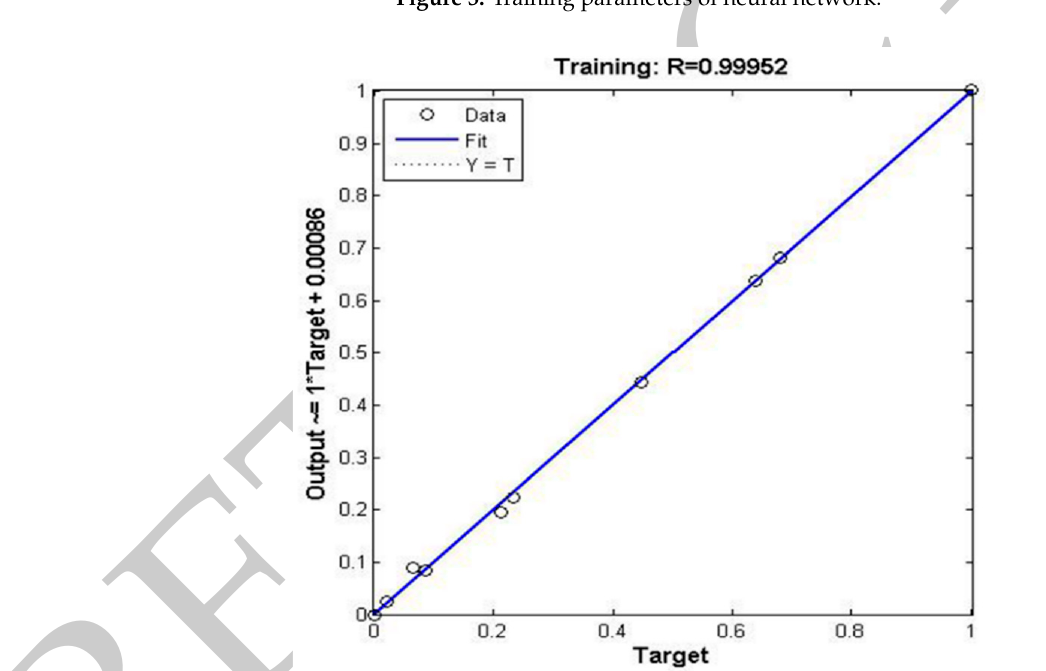
Figure 3. Training parameters of neural network.